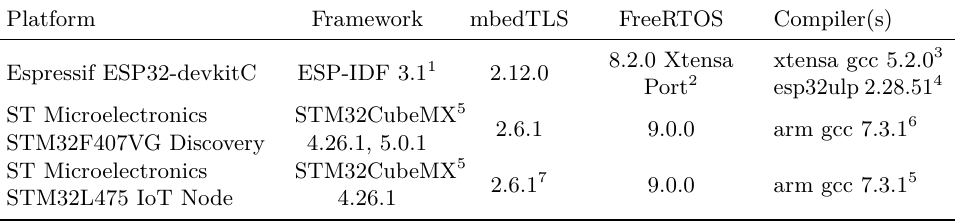
Table 1: Used vendor toolchain versions and respective library and compiler versions